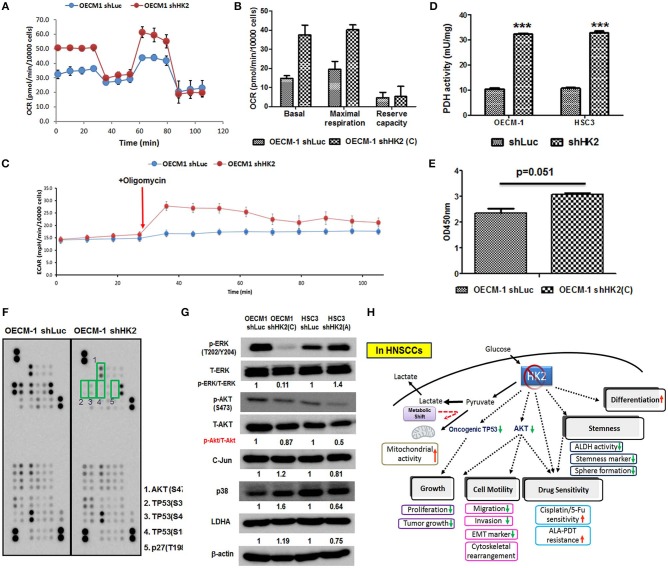
Metabolic and molecular changes in HK2-silencing HNSCC cells. (A,B) Seahorse metabolic analysis showed an elevated basal respiration and maximal respiration in HK2 deficient OECM-1 cells. (C) Sharp increase of ECAR upon addition of ATPase inhibitor oligomycin and (D) increased pyruvate dehydrogenase activity reflected that HK2 loss triggers HNSCC cells toward mitochondrial metabolism. (E) ATP level was slightly increased in HK2-silencing OECM-1 cells. (F) Human protein array analysis for phosphorylated proteins differentially expressed in HK2-silencing OECM-1 cells was performed. Green boxes indicated oncogenic phosphorylated molecules: (1) Akt (S473), (2) TP53 (S392), (3) TP53 (S46), (4) TP53 (S15), and (5) p27 (T198). (G) Western blot analysis confirmed that phosphorylated PKB/Akt proteins is downregulated in HK2-silencing HNSCC cells. p38, P38 mitogen-activated protein kinase; LDHA, lactate dehydrogenase A. (H) Graphic summary of HK2-mediated regulations in HNSCC cells. Data are presented as mean ± SEM (N > 3). ***P < 0.001.